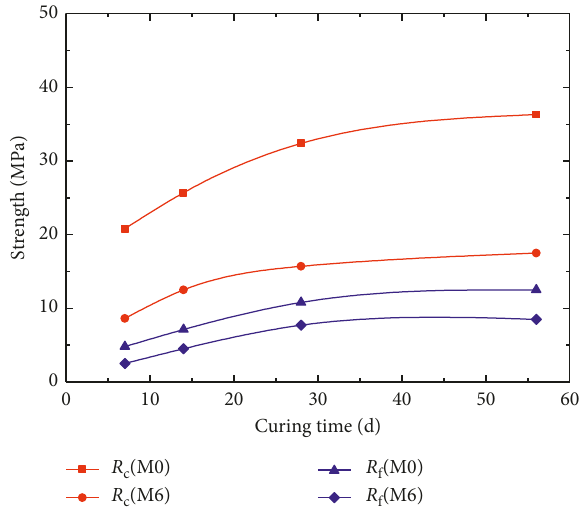
Figure 10: Strength comparison between cement mortar and RHA-lime mortar.